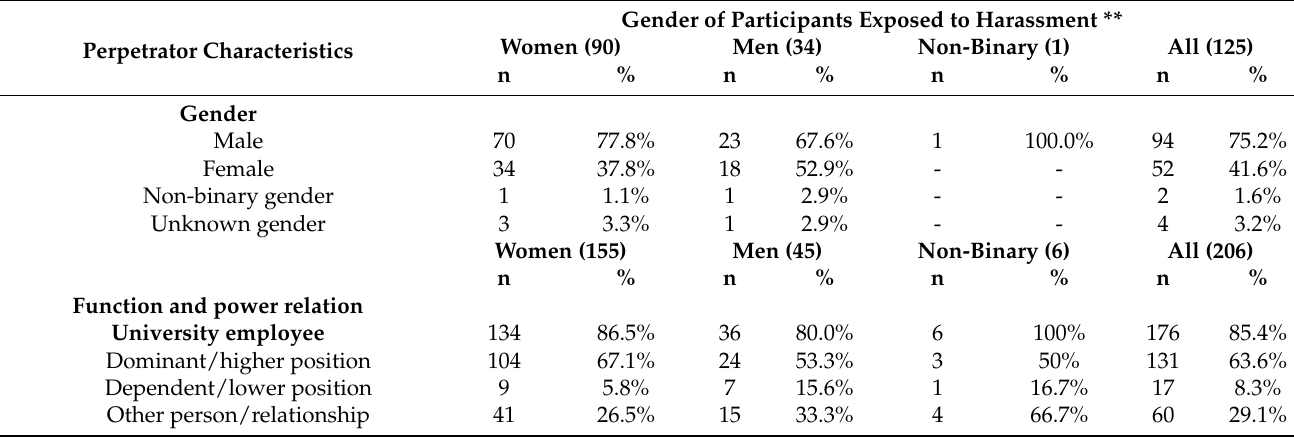
Table 3. Gender, function and power relation of the perpetrator/perpetrators * of harassment associated with the Swedish legal grounds for discrimination, by gender of exposed